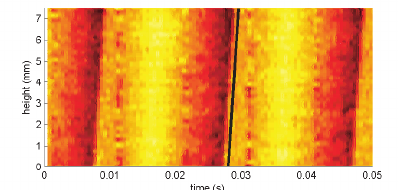
Figure 6. Waves of motion (red) propagate upwards through the imaged region extremely rapidly ( ≈ 60 ms − 1 ), as seen from the steep gradient of these lines.